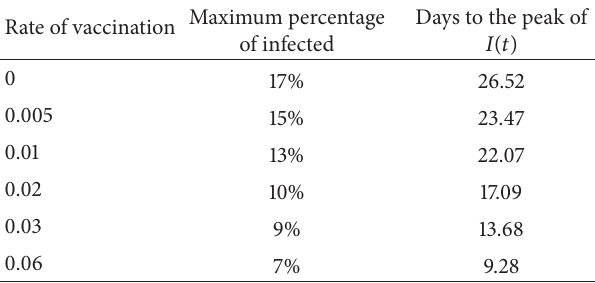
Table 1: Maximum percentage of infected individuals 𝐼 correspond- ing to different rates 𝜐 of vaccination and respective number of days for the peak of 𝐼